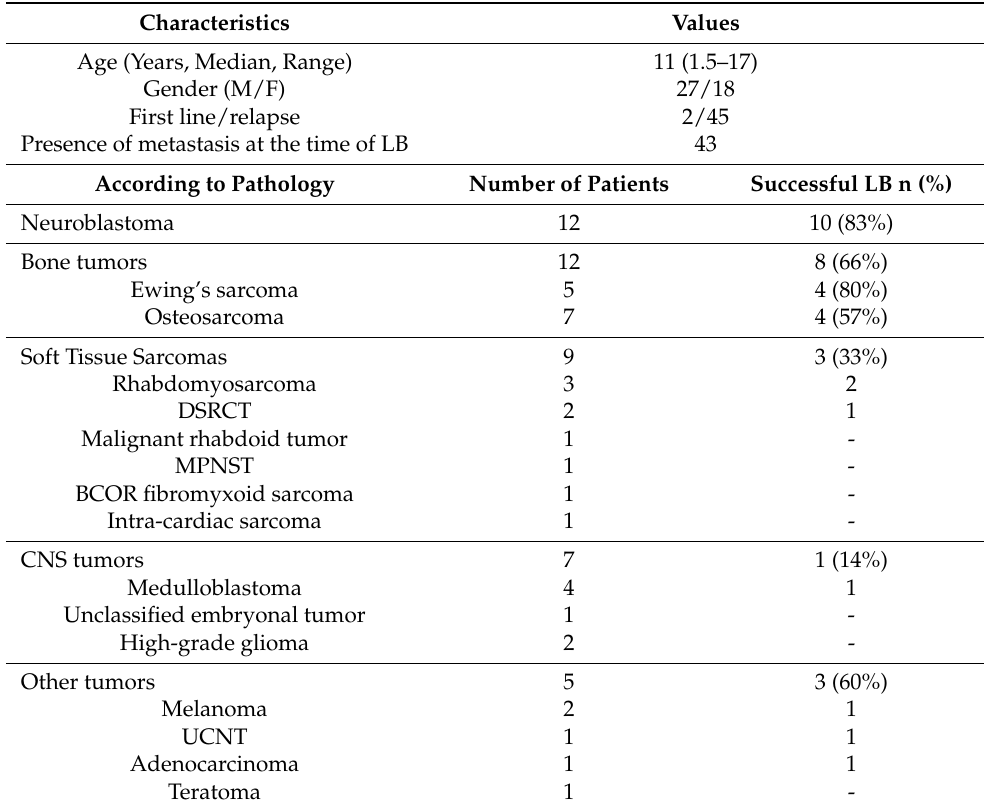
Table 1. Main clinical characteristics of the